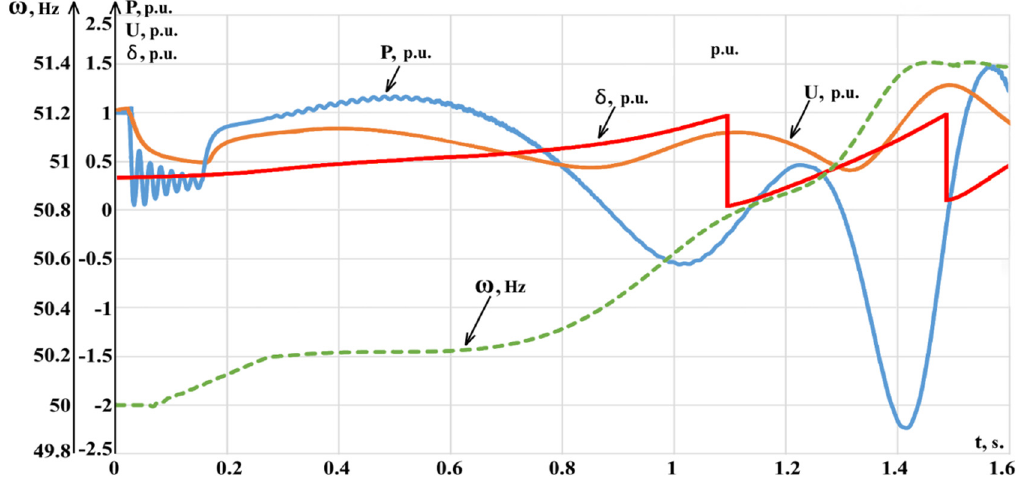
Figure 12. Generator G 2 voltage, active power, and frequency for a case of three ‐ phase short circuit on the B 2 buses.